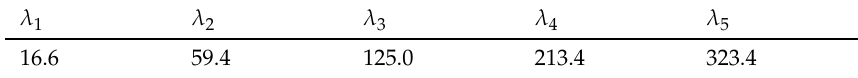
Table 2. Numerical results for eigenvalues of the problem